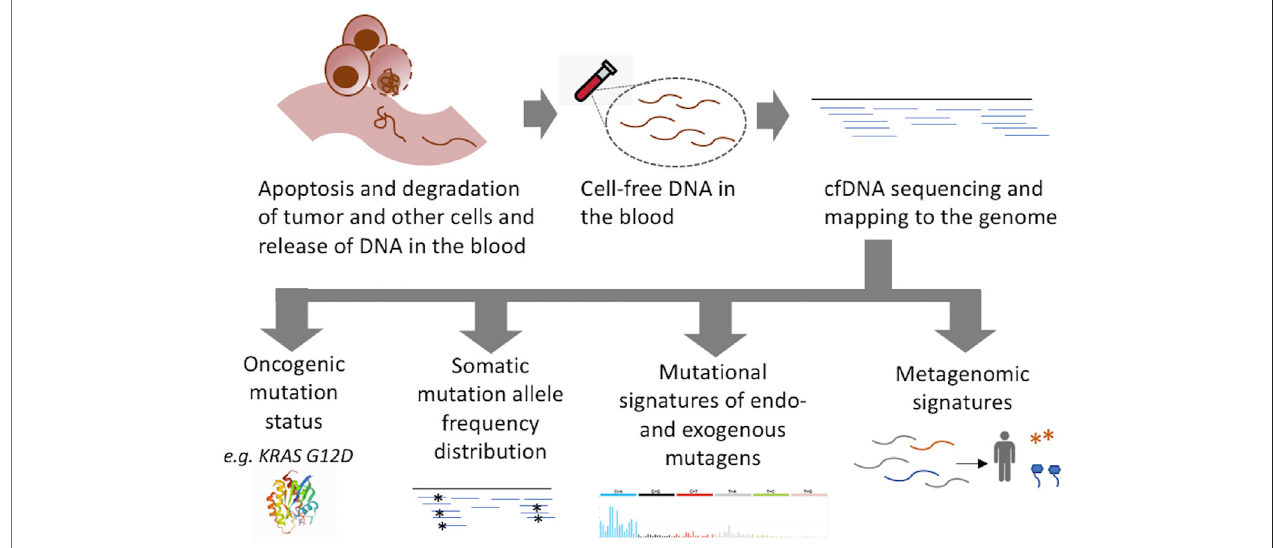
FIGURE 1 | Molecular signatures in liquid biopsy sequencing relevant for early detection of cancer. Sequencing of cell free DNA can provide information about the status of cancer gene mutations as well as prevalent mutational signatures in somatic mutations in clonally ampli fi ed cell populations and microbial DNA, which can predict potential tissue of origin, the extent of clonal growth, and malignant disease